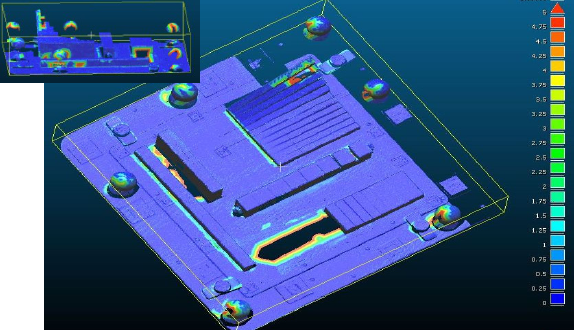
Figure 18 Comparison Arius3D scan vs Nikon MMD. Scale covers a +/- 0.5mm range and demonstrates systematic discrepancies between the two sets of measurement